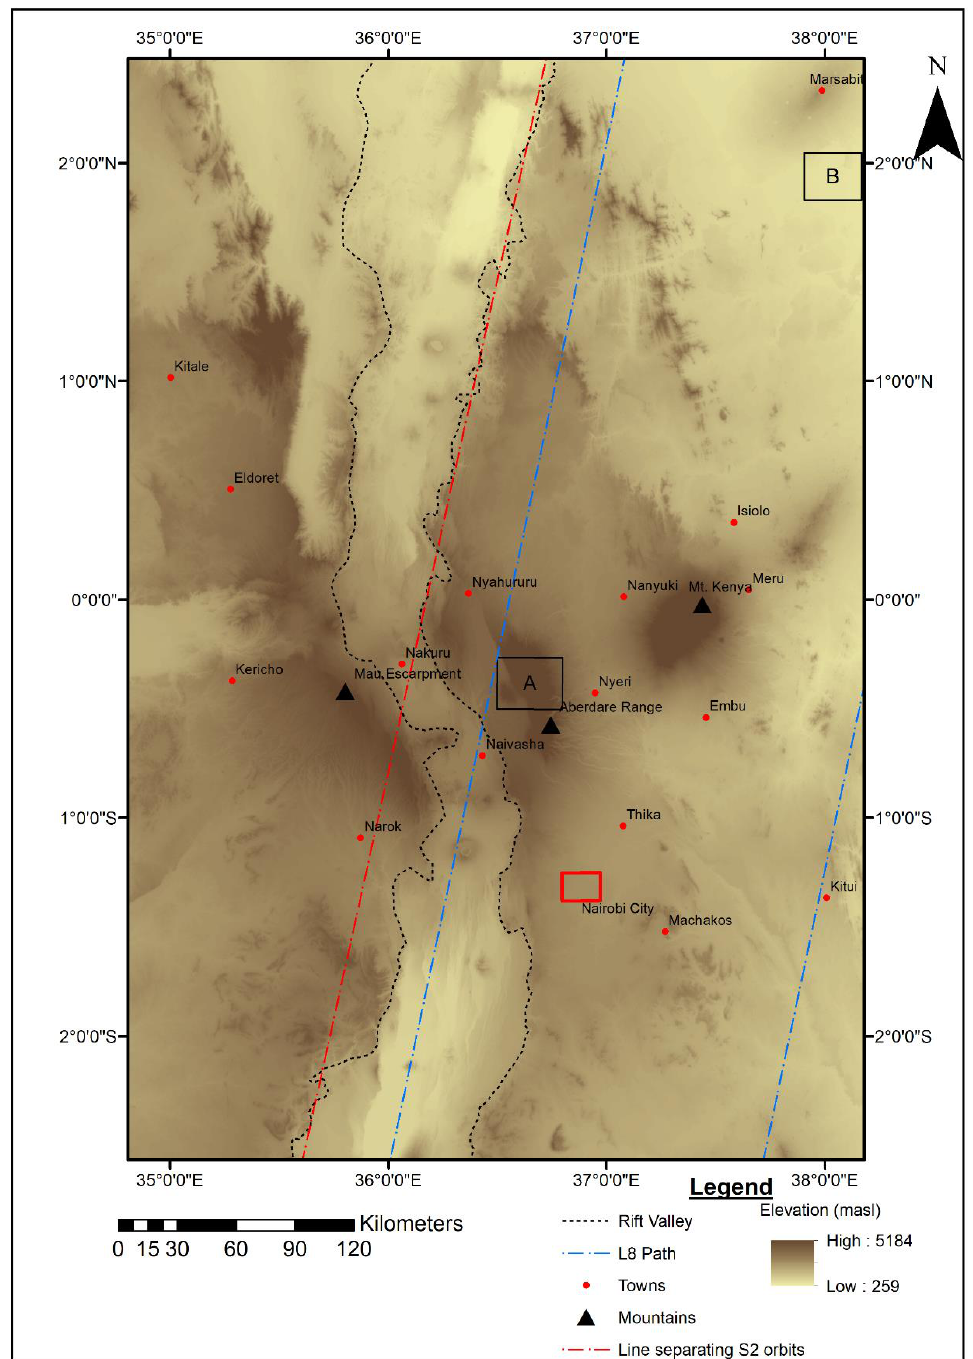
Figure 1. Map showing the study area and the coverage of data Figure 1: Map showing the study area and the coverage of data used.